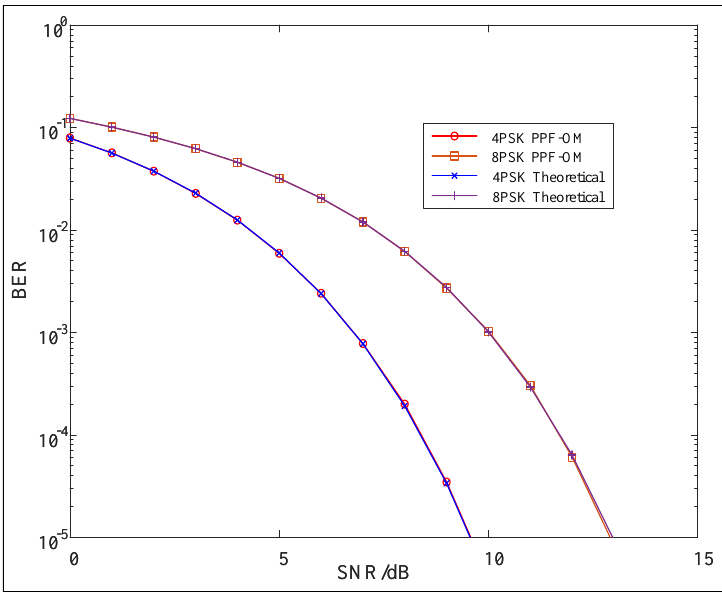
Figure 5. BER performance of PPF-OM